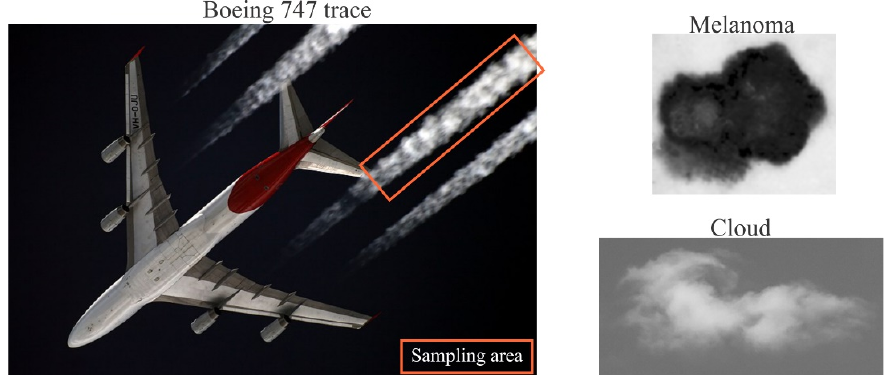
Figure 2. Test images with low edge gradient. Boeing 747 trace. Credit: Contributor Sergey Kustov, Wikipedia [16]. Melanoma. Credit: J. Imaging [17]. Cloud. Credit: personal archive.